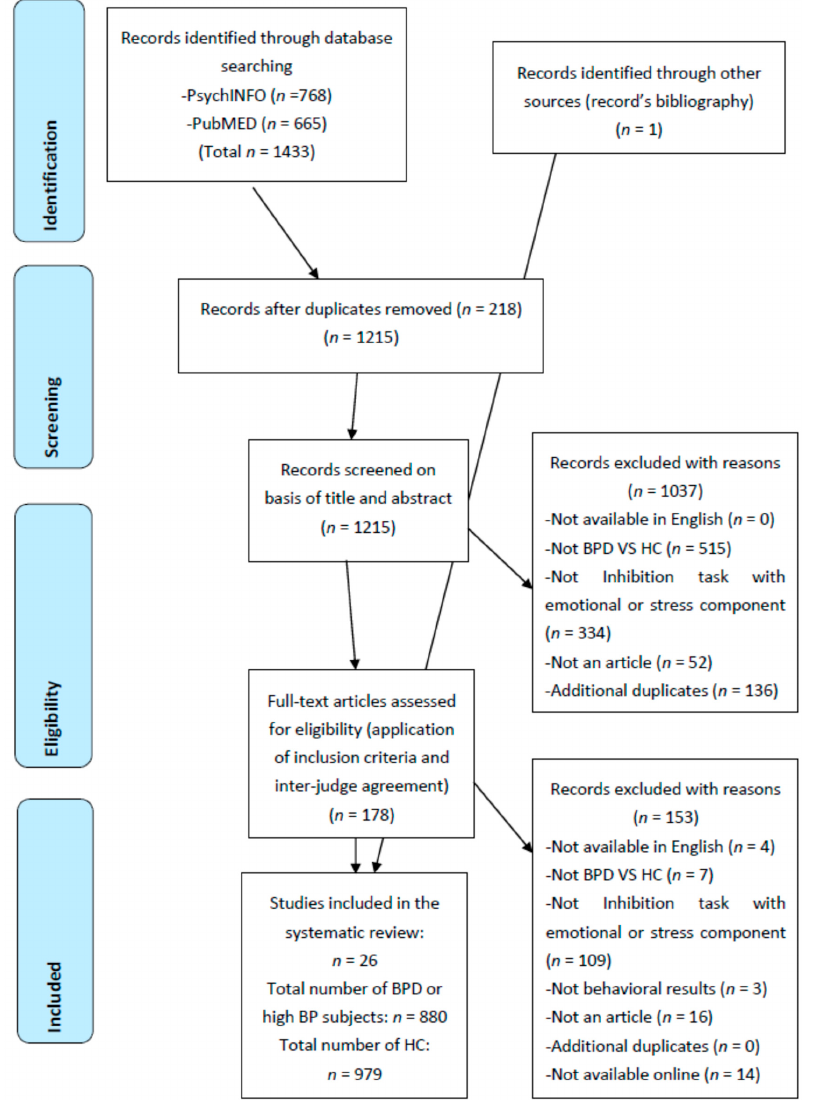
Figure 1. Preferred Reporting Items for Systematic Review and Meta-Analyses (PRISMA) flow diagram of the selection of studies.